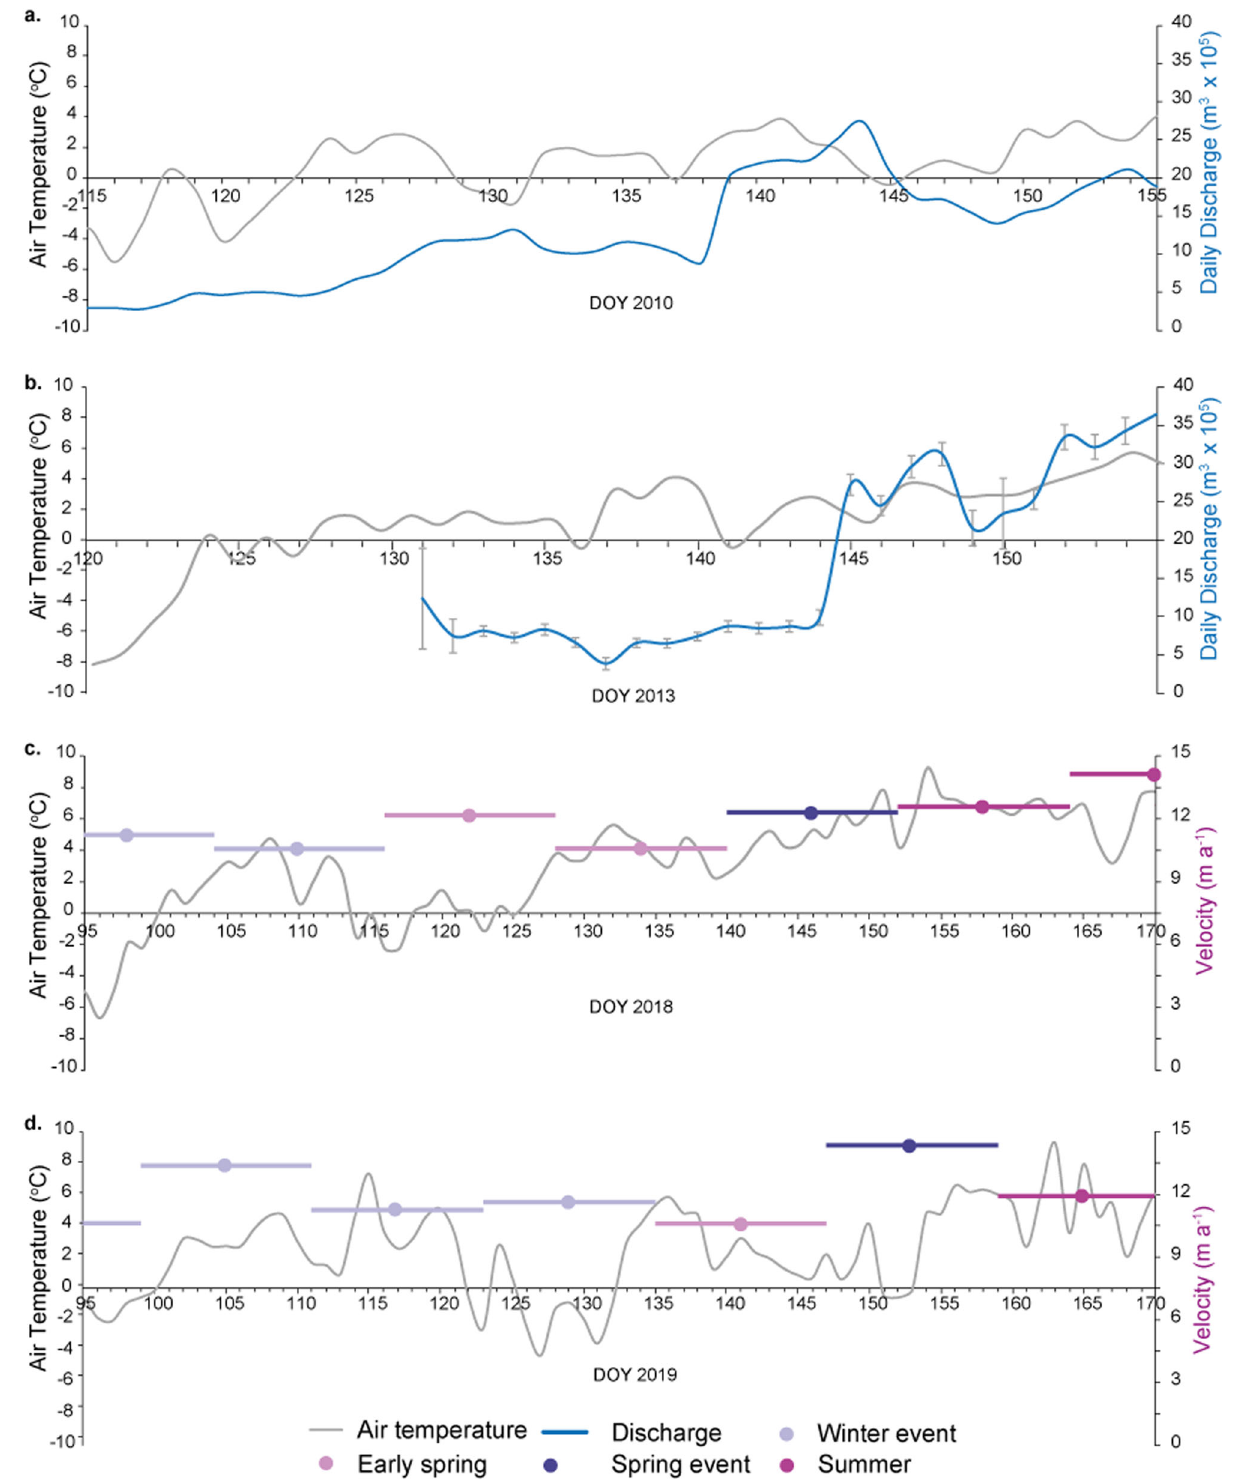
Fig. 5 Changes in discharge, velocity and air temperature during spring for the Sultartungnajökull catchment. a Daily discharge during 2010 from the component of the Kolgríma (see ‘ Methods ’ for detail). Spring begins DOY 123, spring event DOY 139, summer begins DOY 145. b Daily discharge during 2013, spring begins DOY 128, spring event DOY 144, summer begins DOY 148 (calculation of error explained in the ‘ Discharge ’ section in ‘ Methods ’ ). c Twelve-day velocity 2018 (this data has been scaled to the GPS data for comparative purposes, see ‘ Methods ’ for details). Spring begins DOY 128, spring event approx. DOY 143, summer begins DOY 149. d Twelve-day velocity windows 2019. Spring begins DOY 133, spring event approx. DOY 148, summer begins DOY